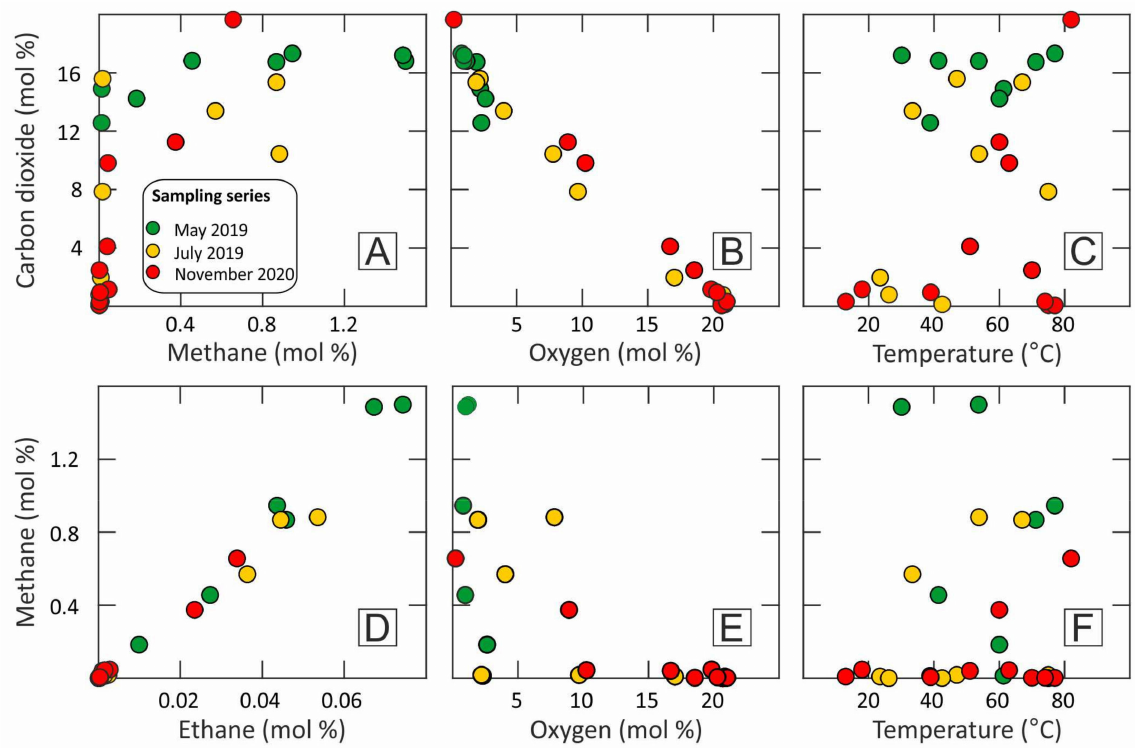
Figure 5. The concentration of carbon dioxide versus ( A ) methane and ( B ) oxygen concentrations and ( C ) temperature at the point of sampling and concentration of methane versus ( D ) ethane and ( E ) oxygen concentrations and ( F ) temperature at the point of sampling of analysed